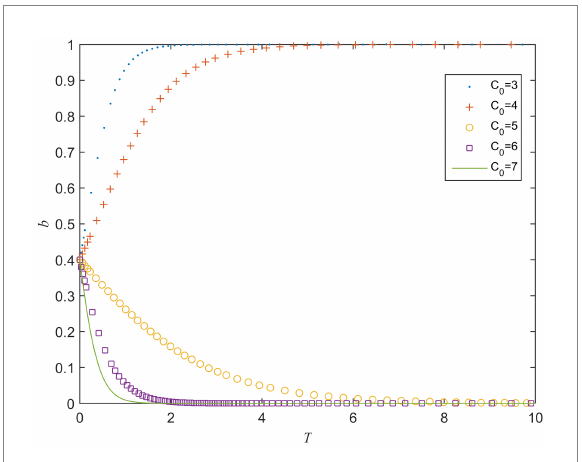
FIGURE 2 Strategy evolution of the private sector under different values of 0 C